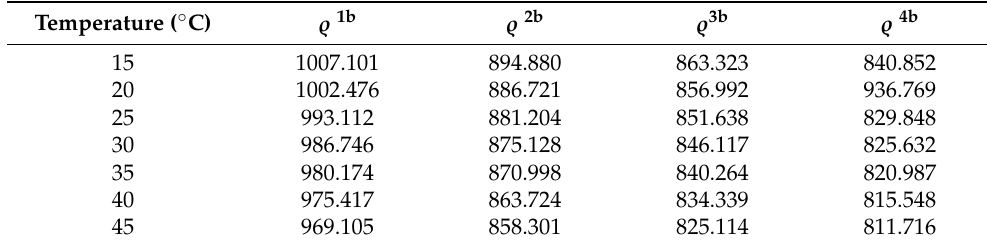
Table 1. Variation of density, (cid:36) (kg/m 3 ) with change in temperature ( ◦ C) and amount of solvents. Temperature ( ◦